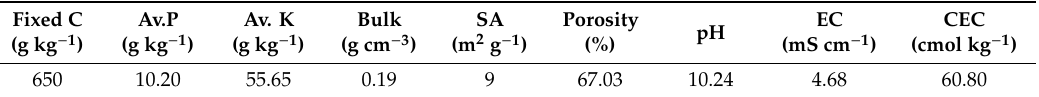
Table 1. Basic properties of biochar in our research. (Fixed C: fixed carbon, Av. P: Olsen available phosphorus; Av. K: available potassium; Bulk: bulk density; SA: surface area; EC: electrical conductivity CEC: cation exchange